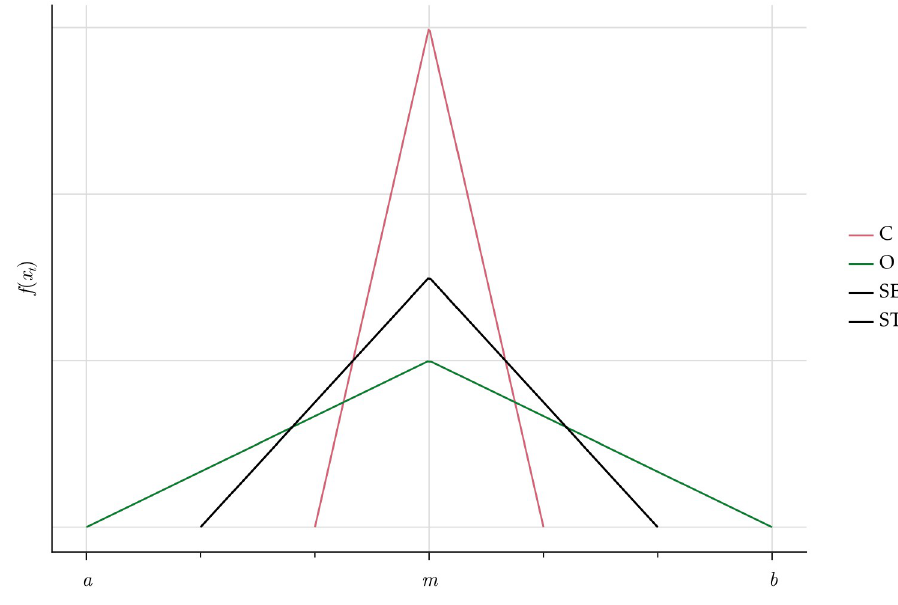
Fig 4. Deviation from